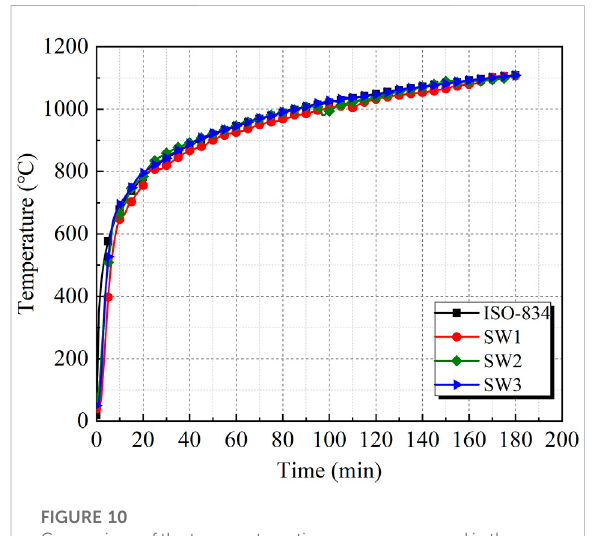
FIGURE 10 Comparisonofthetemperature-timecurvesmeasuredinthe furnace with the ISO-834 standard